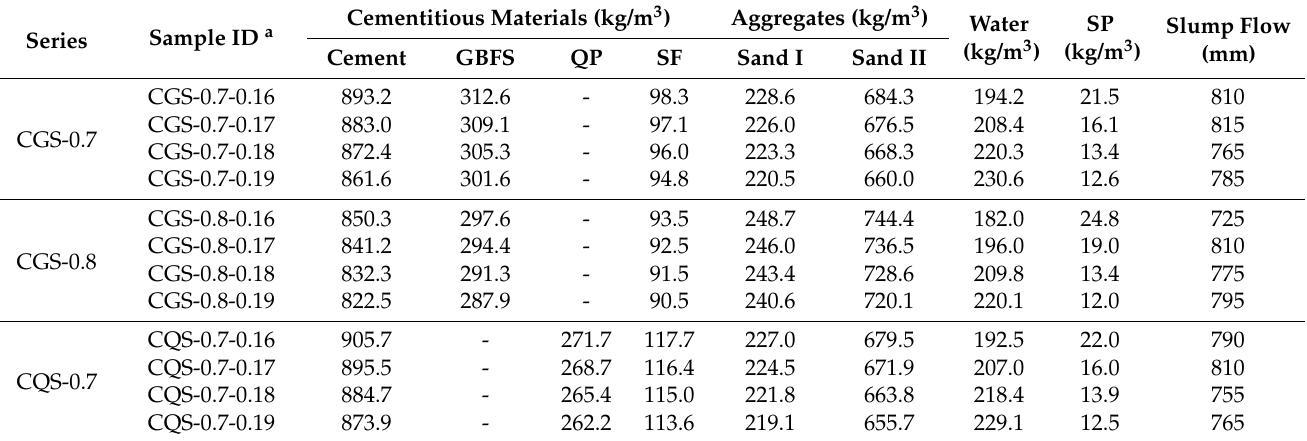
Table 5. Mixture proportions and the slump flow of the UHPC matrices.